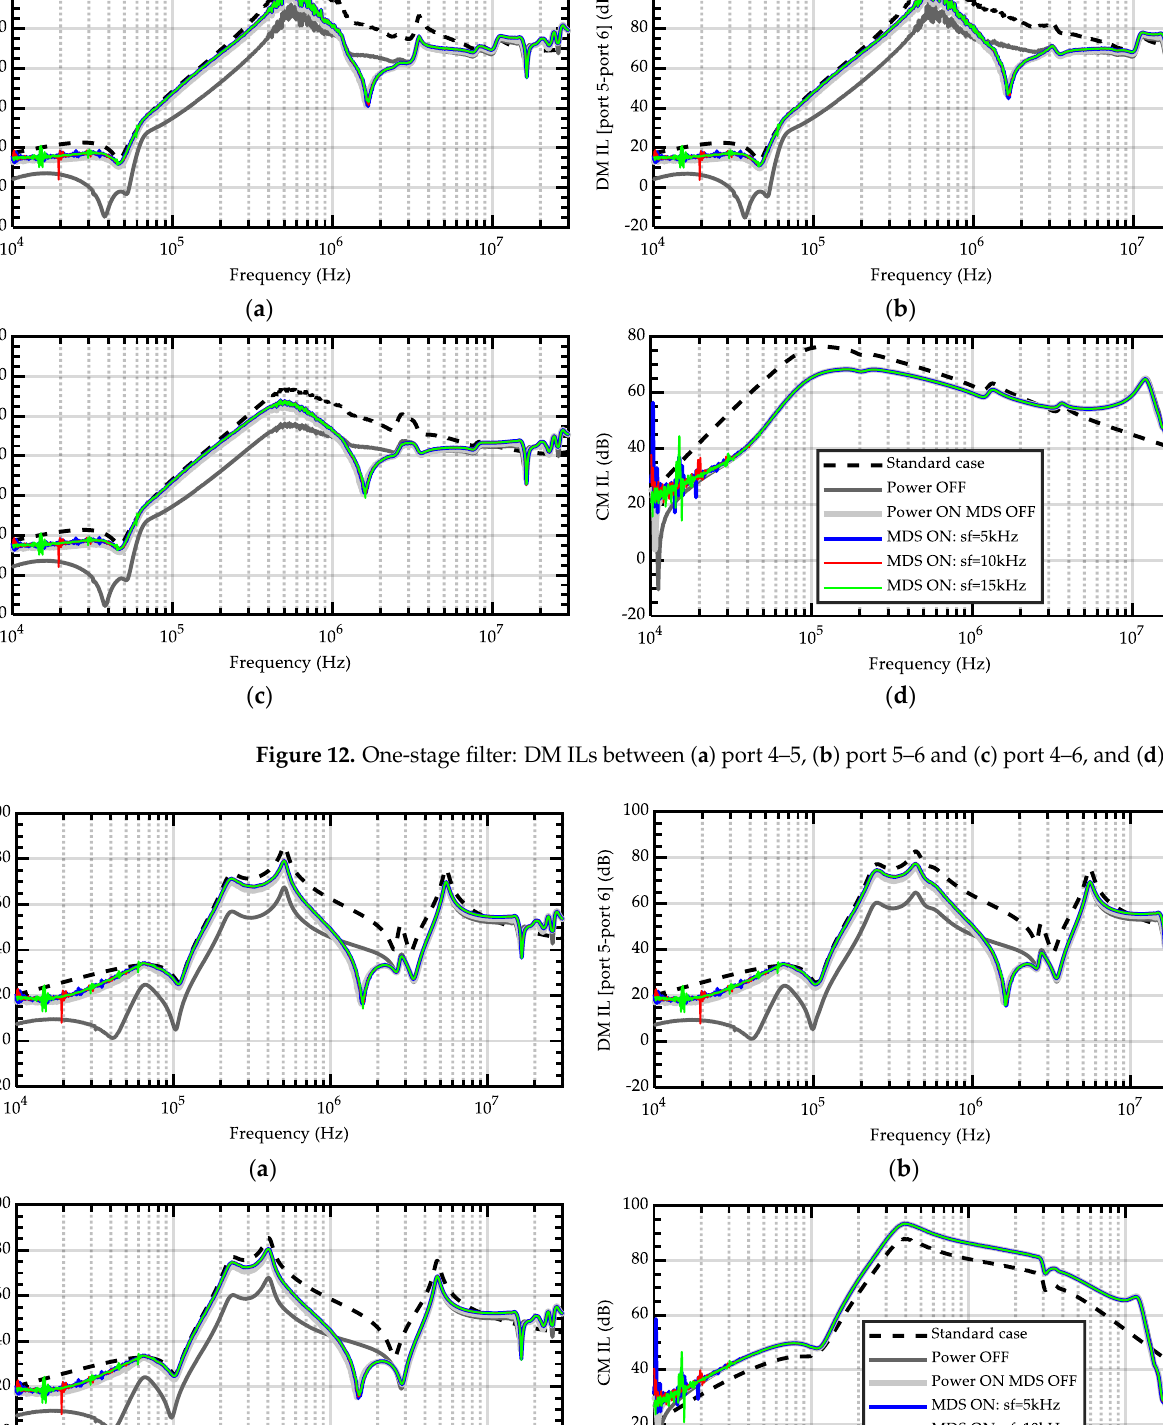
Figure 12. One-stage filter: DM ILs between ( a ) port 4 – 5, ( b ) port 5 – 6 and ( c ) port 4 – 6, and ( d ) CM IL.